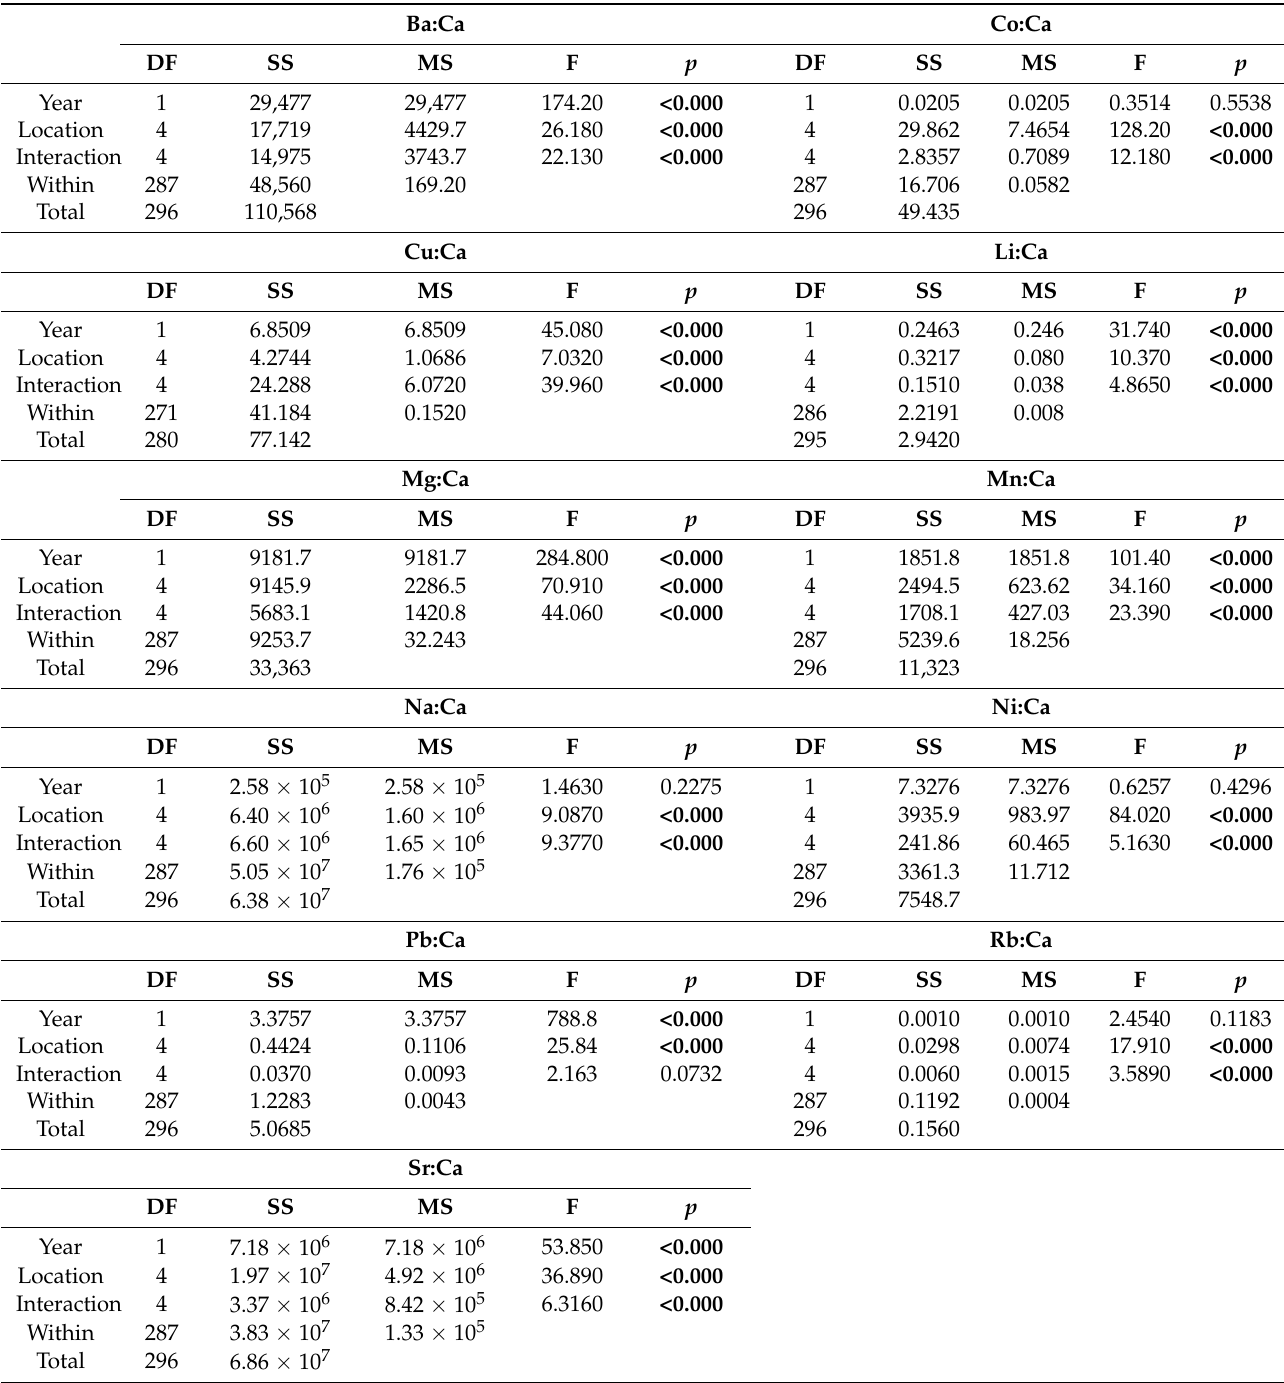
Table 2. Two-Way ANOVA comparisons among the five sampling locations regarding the chemical composition of Isopisthus parvipinnis otoliths collected in 1975 and 2018/2019. Statistically significant differences ( p < 0.05) were marked in